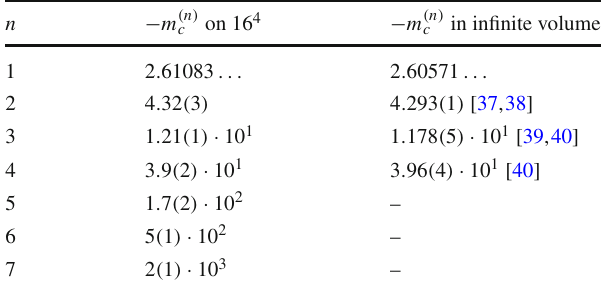
( n ) ( n + 1 ) = 3, N = 2 Wilson fermions deter- c on m c and higher Table 1 Critical masses for N c f mined with NSPT on a 16 4 lattice with twisted boundary condition on a plane, compared with the known values in infinite volume. The n =